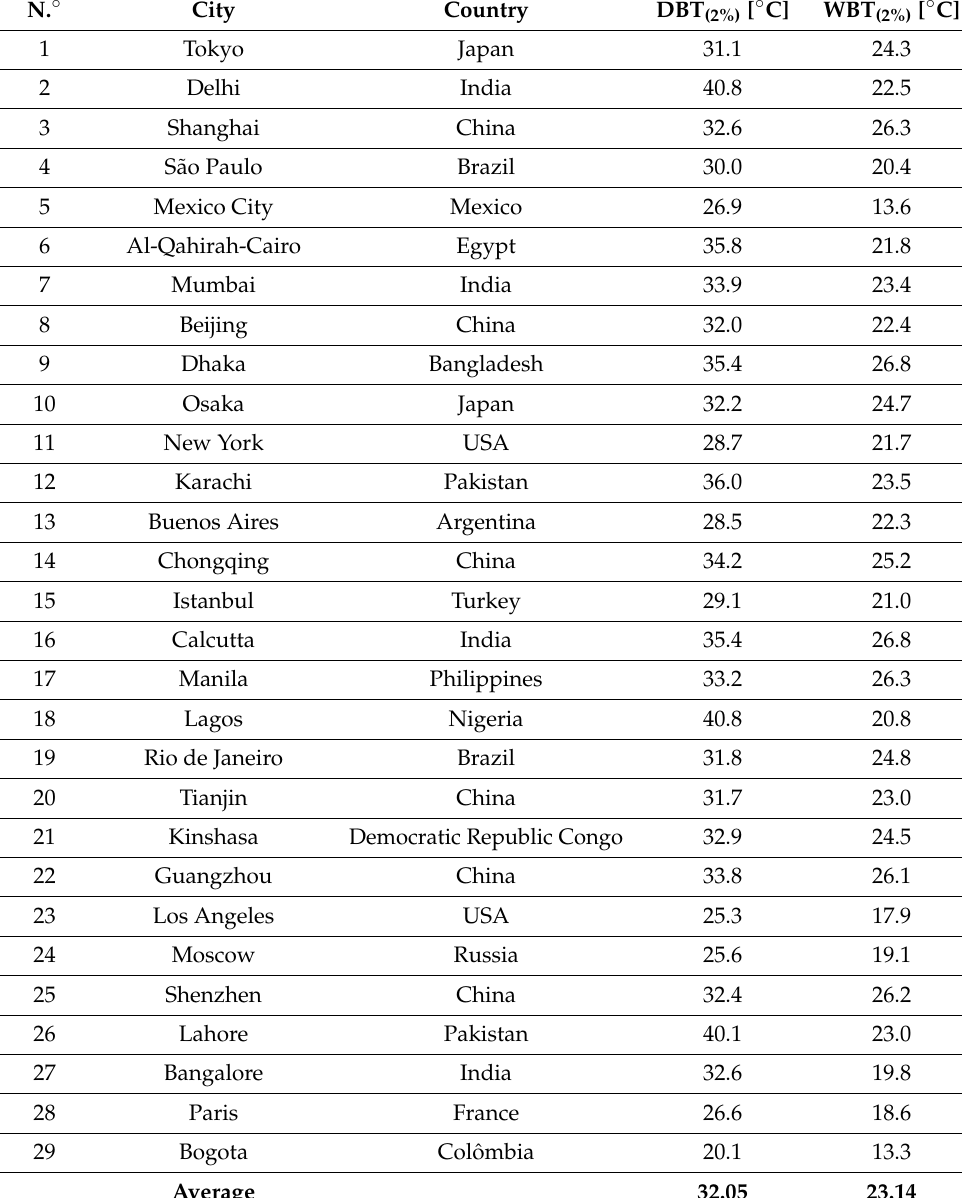
Table 2. Single and dry-bulb temperature